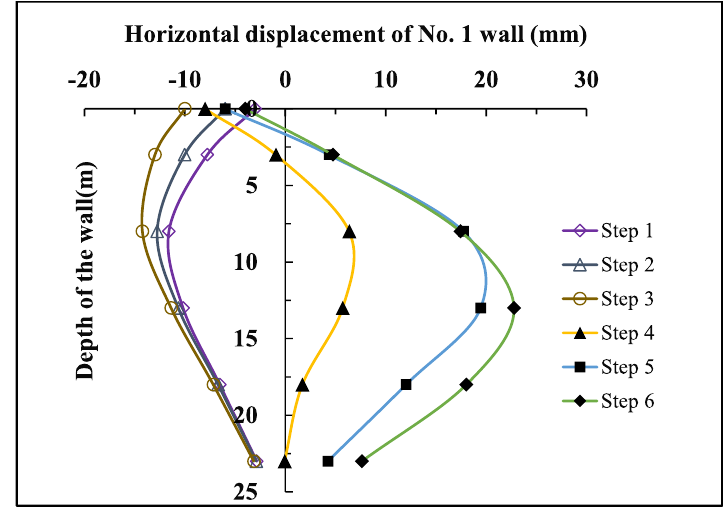
Figure 6. Horizontal displacement of wall No. 1.